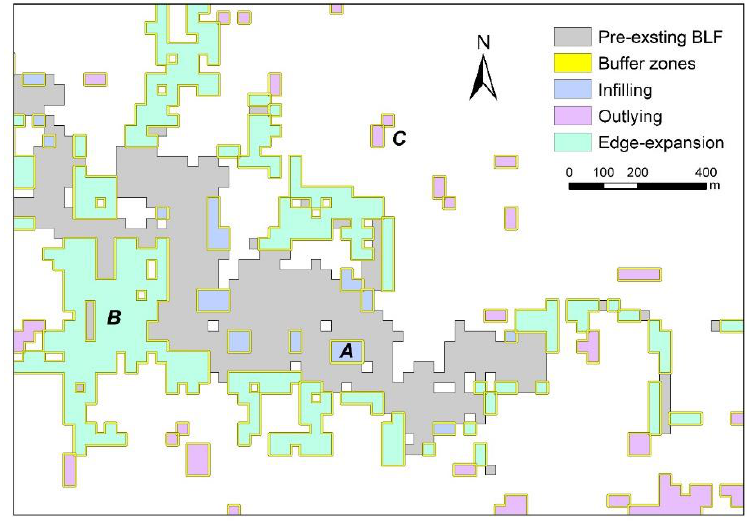
Figure 5. The identification of the di ff erent expansion types of BLF patches using landscape expansion index (LEI). ( A – C ) indicate infilling patches, edge-expansion patches, and outlying patches, respectively.